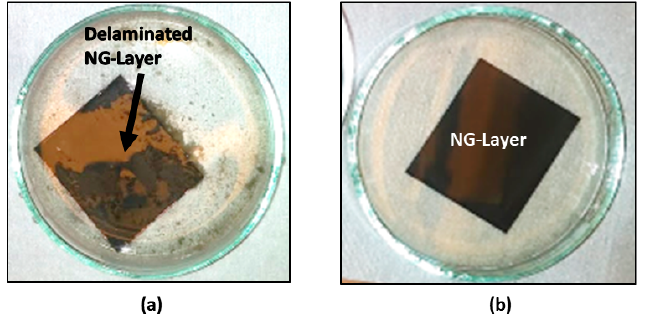
Figure 1. ( a ) NG layer removed from the surface of Cu foil during the seeding process, resulting from ultrasonic agitation with high level fluid; ( b ) NG/Cu substrate with NO NG layer delamination by using solution with fluid surface level just above the substrate surface.